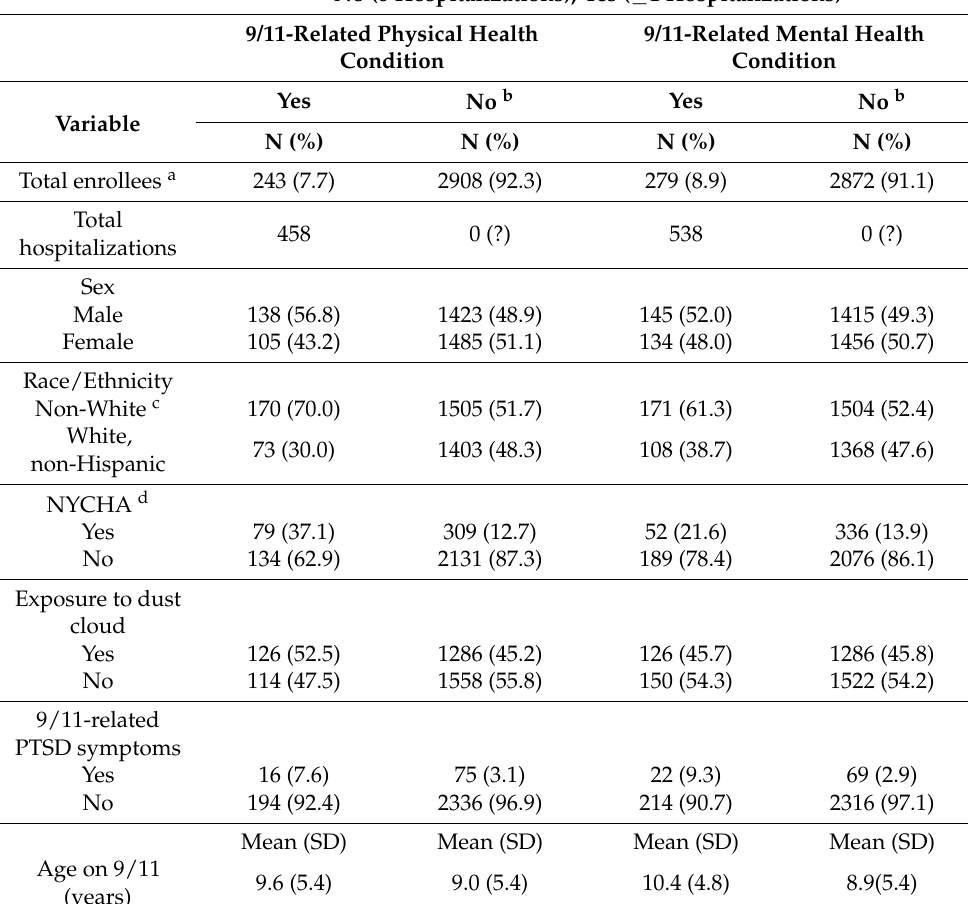
Table 2. Distribution of 9/11-related physical and mental health conditions vs. hospitalizations,